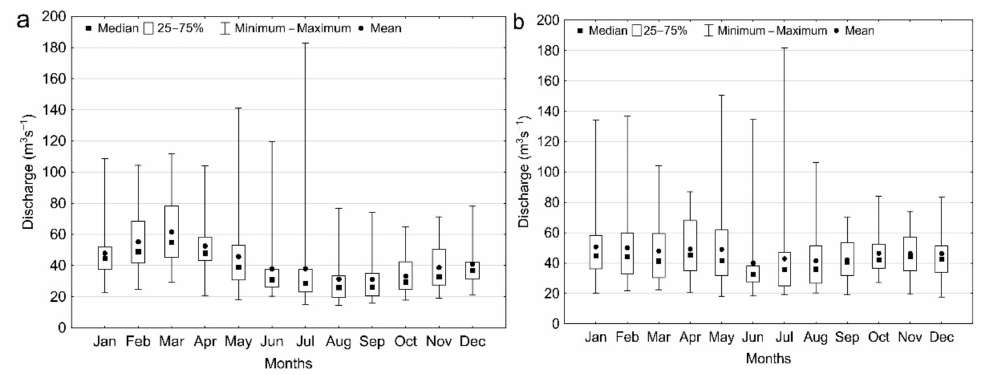
Figure 8. Changes in mean monthly water flows in hydrological stations Sieradz ( a ) and Uniej ó w ( b ) in the period 1995–2021.